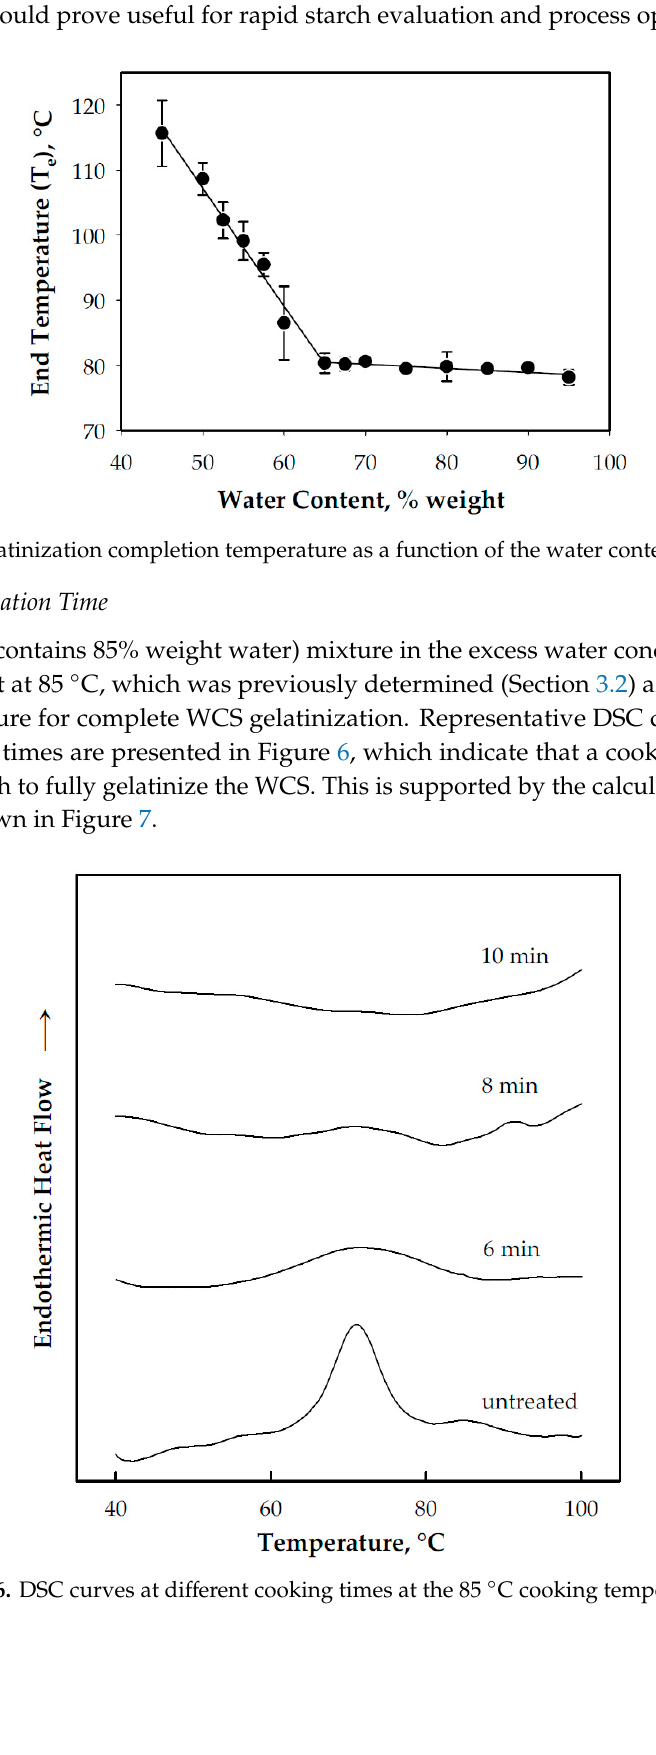
Figure 7. Gelatinization progression as indicated by the disappearance of residual enthalpy, ∆ H r , at the 85 °C treatment temperature. The obtained cooking time (~10 min) for WCS at the excess water condition and 85 °C was much higher than the one (2–3 min) obtained for rice starch [9]. This was likely due to the differences in the nature and source of the starch which, as previously mentioned, dictate starch’s thermal